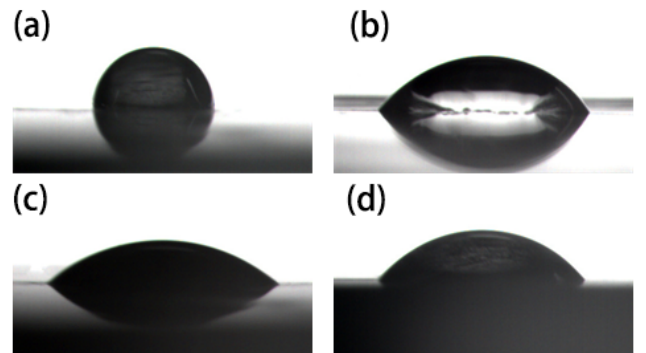
Figure 5. Pictures of water droplets on the surface of the epoxy sample. Front view ( a ) and side view ( b ) of the droplet, after the tracking process in Region B; front view ( c ), and side view ( d ) of the droplet after tracking process in Region C.